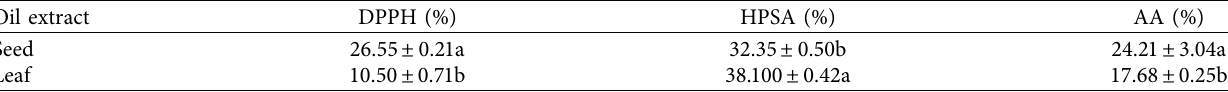
Table 2: Antioxidant activities of garden cress seed and leaf oil extracts.